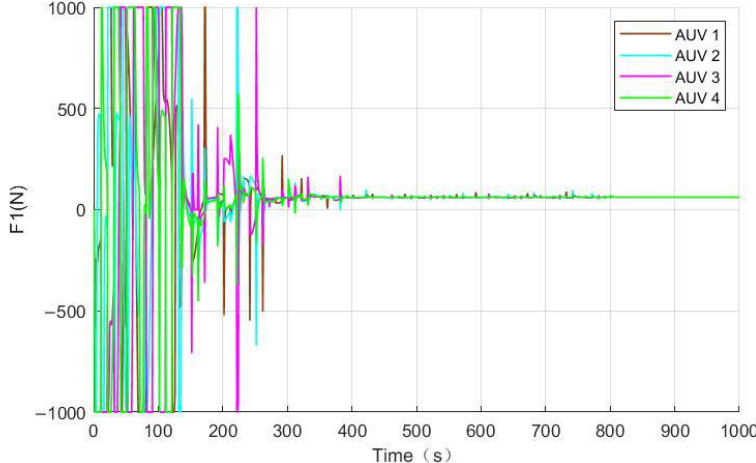
Figure 14. Thrust in the x-direction of the nonlinear model of the followers.